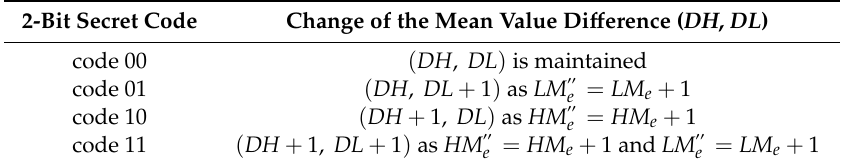
Table 2. Rule of inter-block embedding.